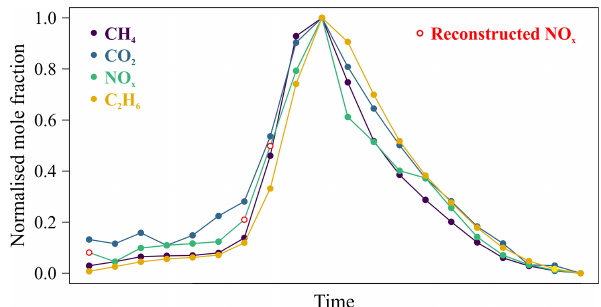
Figure 2. Normalised mole fraction (enhancements above back- ground) for a plume containing CO 2 , CH 4 , C 2 H 6 , and NO x . Three NO x data points were missing and were interpolated and recon- structed using the mean of normalised mole fractions of CO 2 and CH 4 (red data